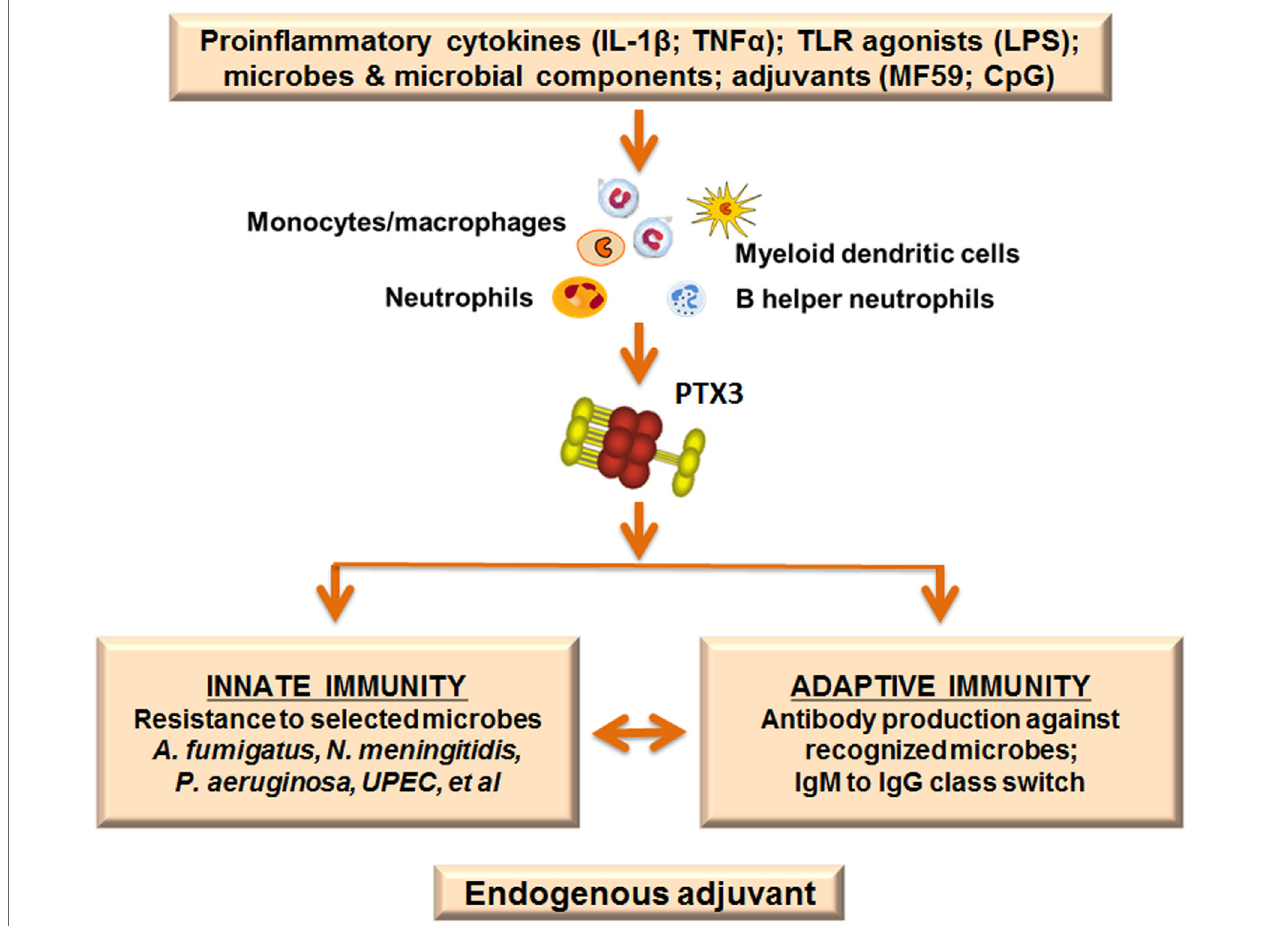
FiGURe 3 | Pentraxin 3 (PTX3) as endogenous adjuvant. PTX3 is locally produced at sites of infection or inflammation by myeloid cells in response to primary pro-inflammatory cytokines and toll-like receptor (TLR) engagement. In addition, the PTX3 gene is rapidly upregulated after treatment with selected adjuvants (MF59; CpG). PTX3 plays essential roles in the immune response to recognized pathogens: it is an active player in the innate immune response to microbes, acting as an opsonin and enhancing phagocytosis. Moreover, PTX3 is involved in immunoglobulin production and class switching from IgM to IgG, promoting humoral adaptive responses. The function of PTX3 as a bridge between the humoral arms of the innate and adaptive immune systems is in agreement with a role as endogenous